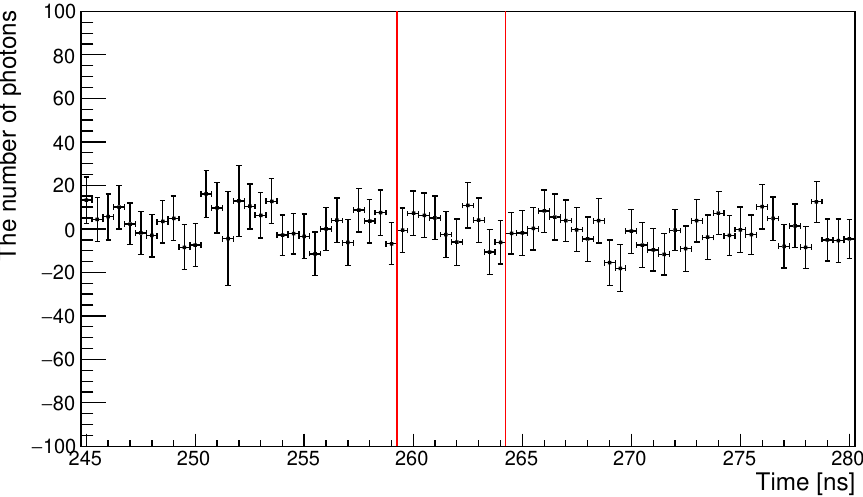
Figure 12 . Arrival-time distribution of number of photons obtained by applying eq. (4.1) to the entire timing windows including the signal window enclosed by the two red lines at 2 . 6 × 10 − 5 Pa by combining the P-polarization state (creation) and the left-handed circular polarization state